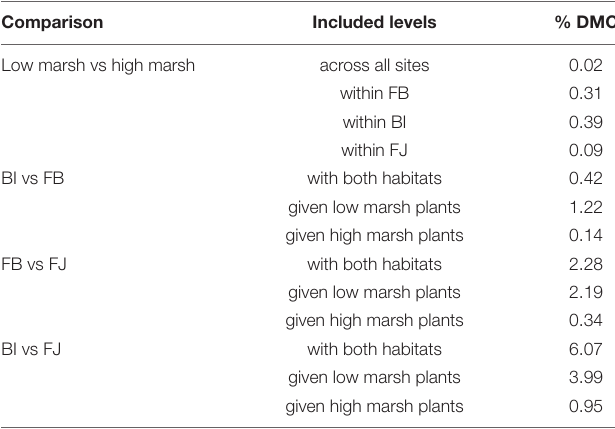
TABLE 5 | Summary of results of linear contrasts to evaluate variation in methylation at each individual cytosine with the package DSS (version 2.24.0; Park and Wu,